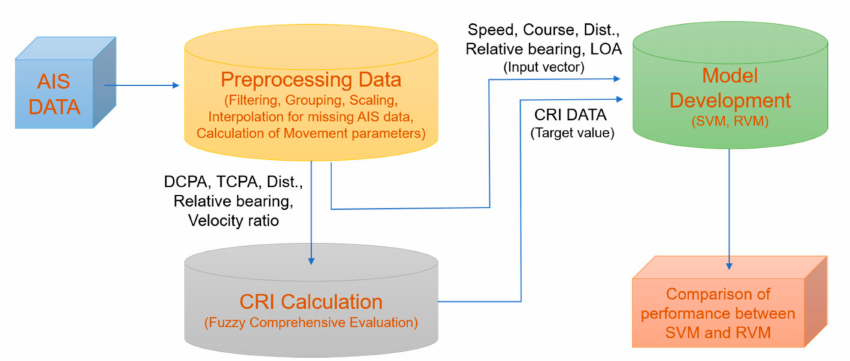
Figure 1. Proposed method for estimating the CRI with AIS